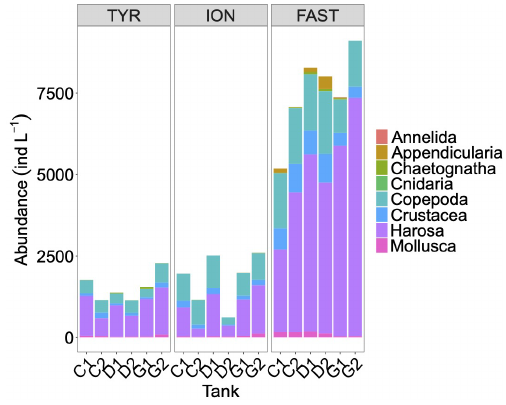
Figure 9. Abundances of meso-zooplankton species as measured in each tank at the end of the experiments at TYR, ION and